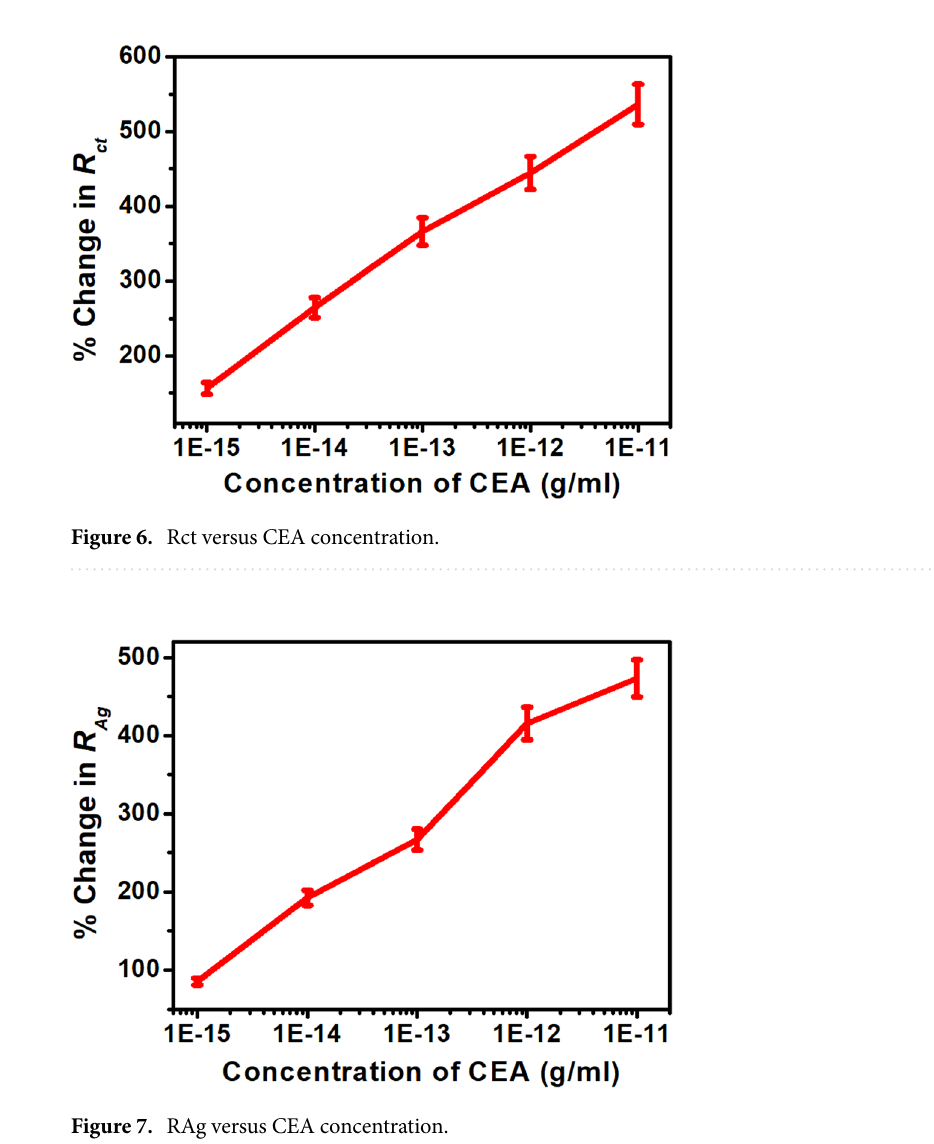
Figure 5. Equivalent circuit diagram.